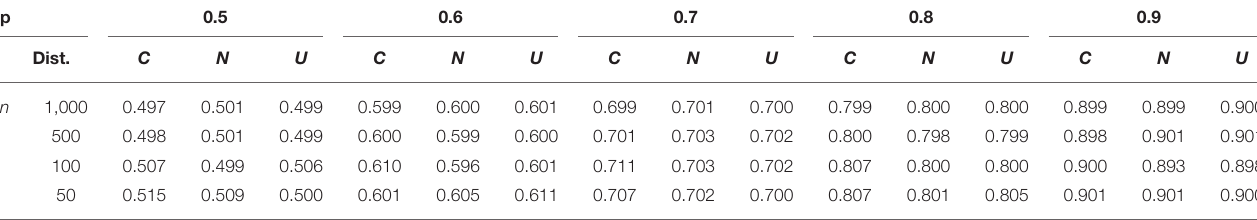
TABLE 4 | Estimated probabilities ˆ p for p i ≡ p , p i ∼ N ( p ,0.3 2 ) and p i ∼ U ( p − 0.3, p + 0.3)*.